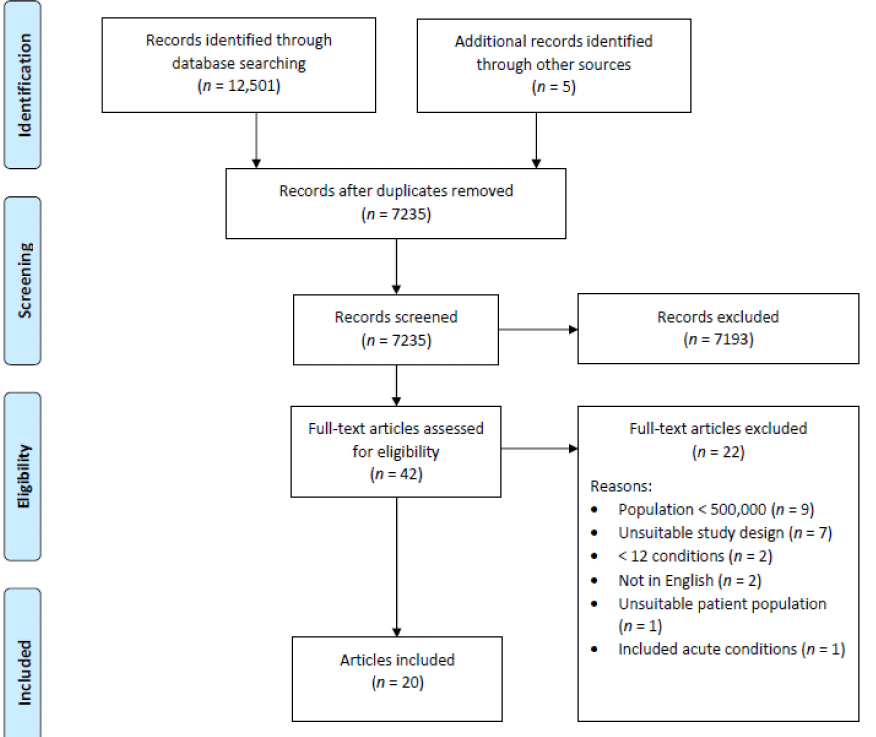
Figure 1. Preferred Reporting Items for Systematic Reviews and Meta-analysis (PRISMA) flow